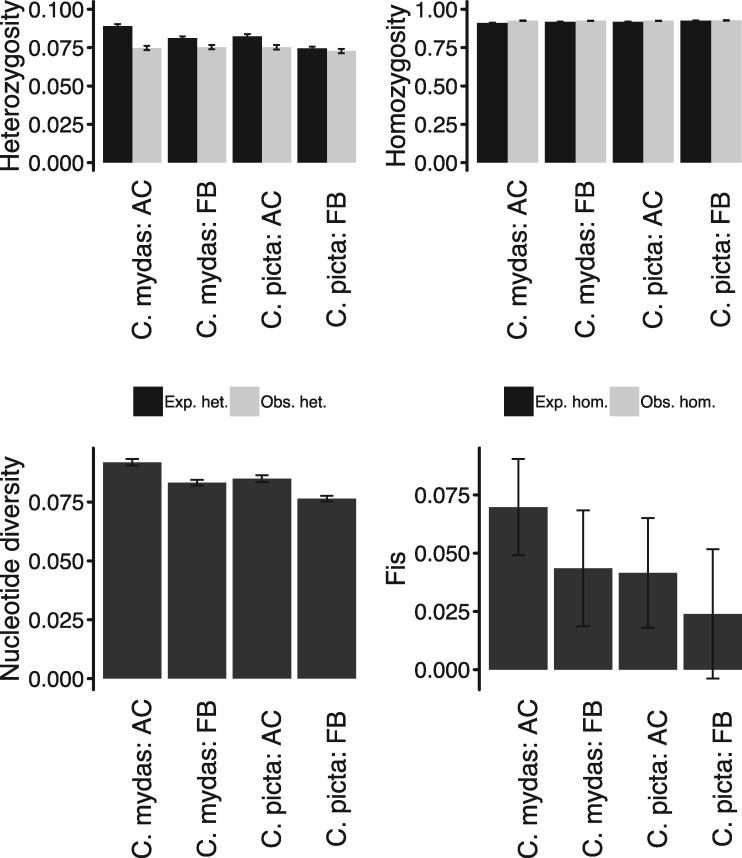
—Population genetics statistics. Mean observed and expected heterozygosity and homozygosity, nucleotide diversity, and inbreeding coefficients are displayed for variant sites with standard error bars for Florida Bay (FB) and Atlantic (AC) loggerheads using either Ch. mydas or Chr. picta as a reference during SNP calling.